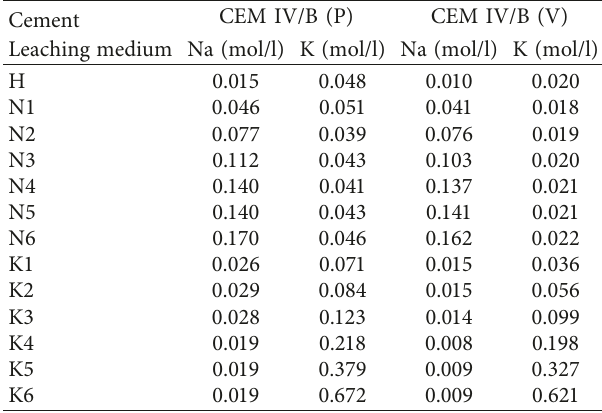
Table 5: Results of leaching tests on monolithic specimens of hydrated cement pastes.